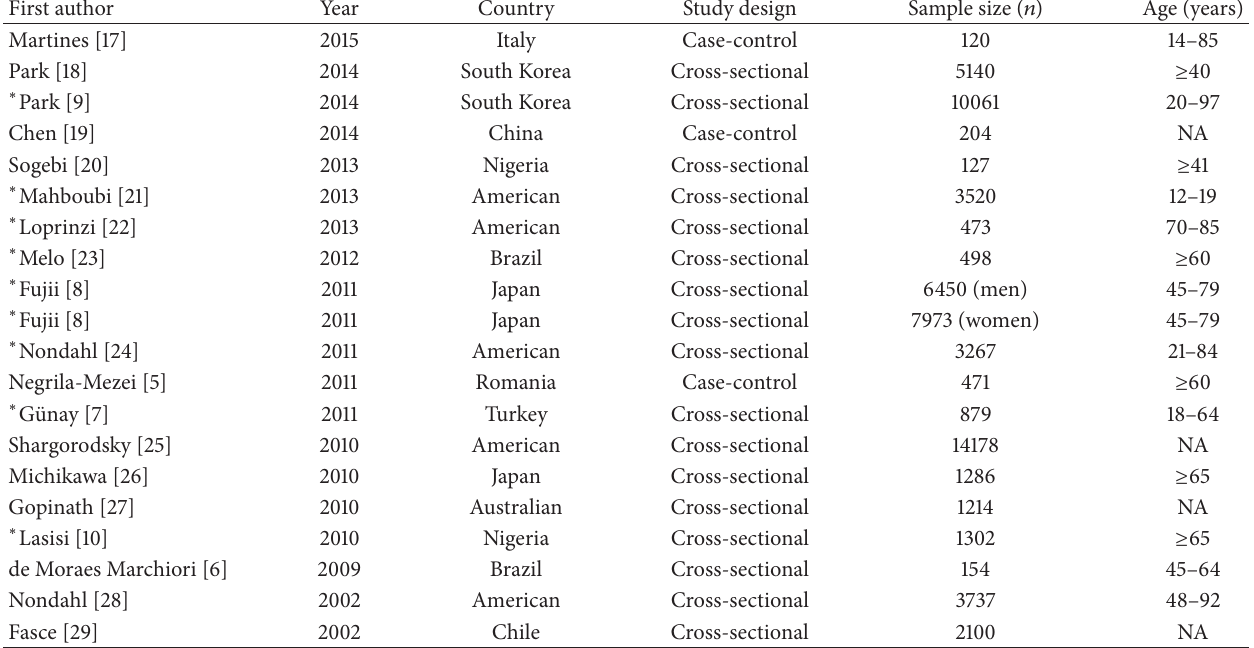
Table 1: Description of the study populations included in the meta-analysis ( 𝑛 = 63154 ).